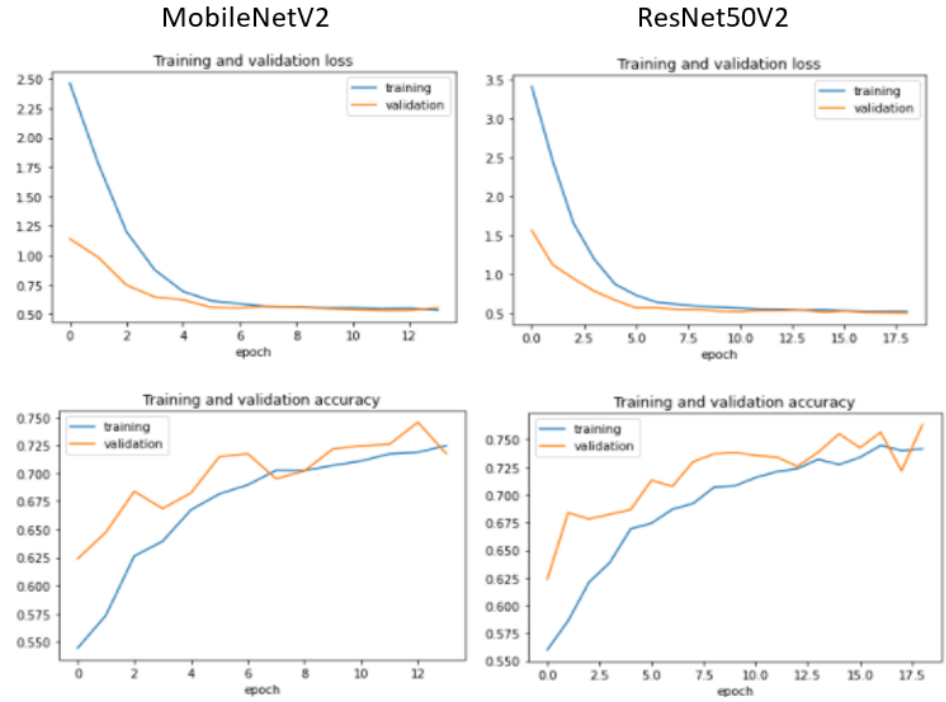
Figure 7. Training and validation performance for MobileNetV2 and